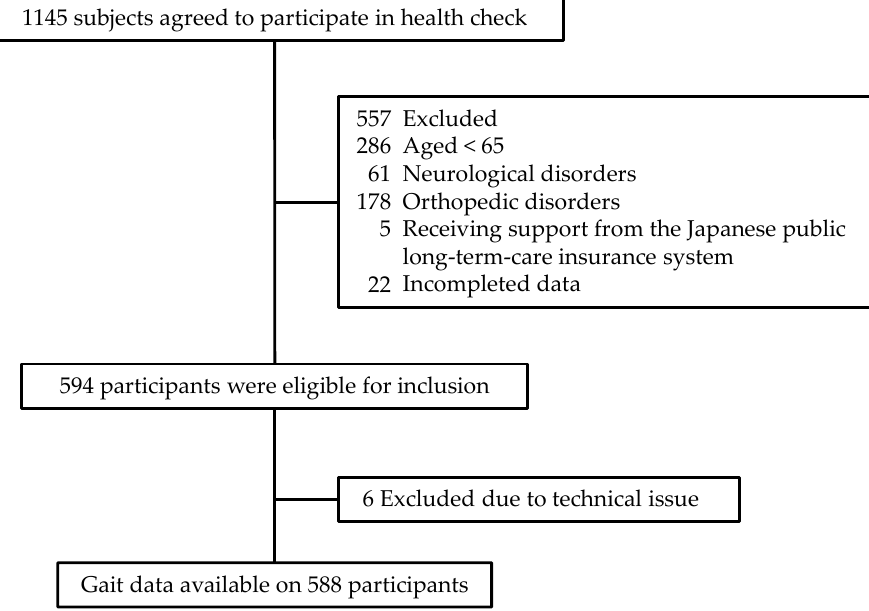
Figure 1. Subject flow diagram from initial contact through to study completion.